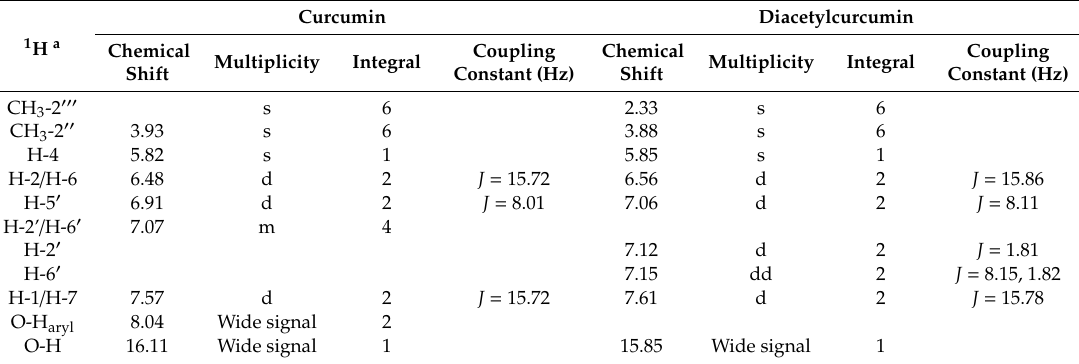
a DatarecordedinCDCl 3 . Chemicalshifts( δ )areexpressedinppmwithrespecttotetramethylsilane(TMS).Assigned coupling patterns: s = singlet, d = doublet, dd = doublet of doublets, m = multiplet. All assignments were derived